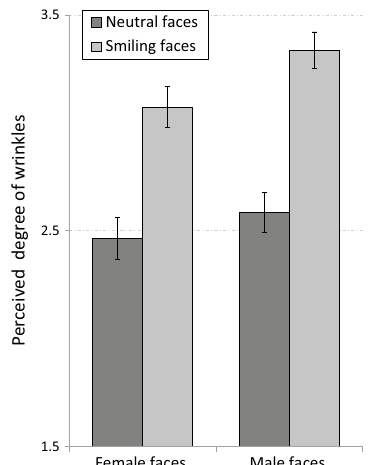
Figure 4. Mean rating of the prominence of wrinkles in the eye region of middle-aged faces. Smiling faces were perceived as containing a greater degree of wrinkling than neutral faces. In addition, male faces were perceived as containing more wrinkles than female faces, an effect which was found mostly for smiling faces. Error bars represent standard errors of the